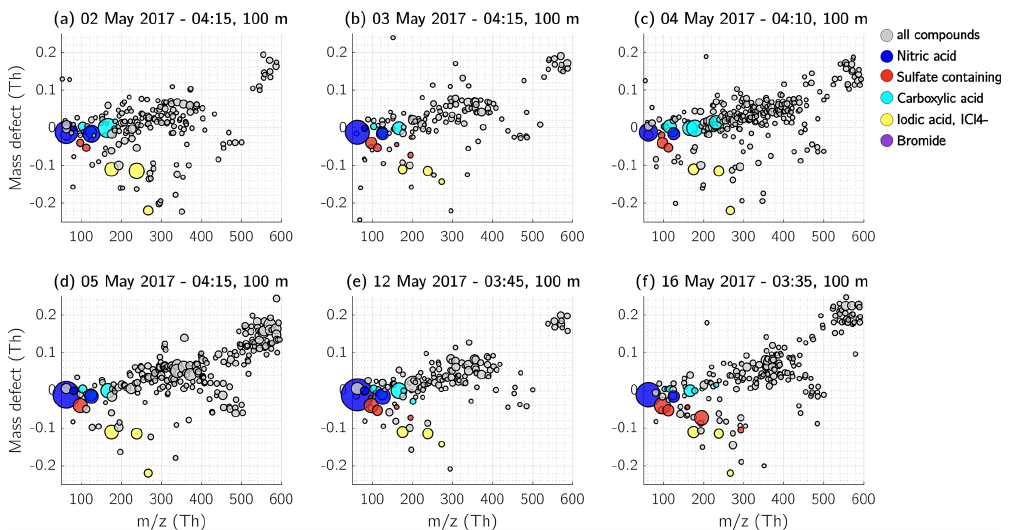
Figure 12. Mass defect of the detected ions in the SBL at 100m height. Each measurement day is shown separately. Nitric-acid-containing ions are coloured dark blue, and ions and clusters with sulfuric acid, MSA, or both, and the SO − containing carboxyl functional groups are shown in cyan, and iodic acid and iodine-containing compounds are shown in yellow. The size of the dots corresponds to the measured signal (ionss − 1